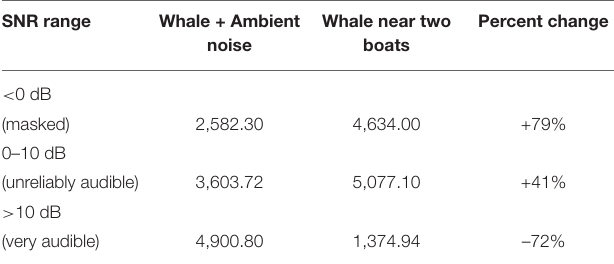
TABLE 3 | Area (km 2 ) that three SNR-binned audibility ranges occupy within the simulation for the September 20, 2019, scenario #2 (single whale alone with ambient noise vs. single whale in close proximity to two boats plus ambient